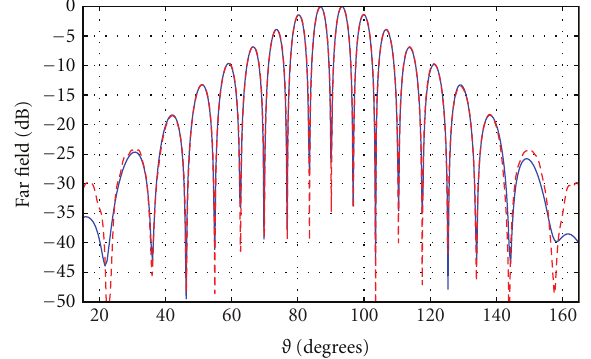
Figure 18: Dual horn, horizontal polarization, di ff erence pattern. ϑ cut of the ϕ component of the far field. Blue solid line: proposed approach. Red dashed line: approach in [7, 8].